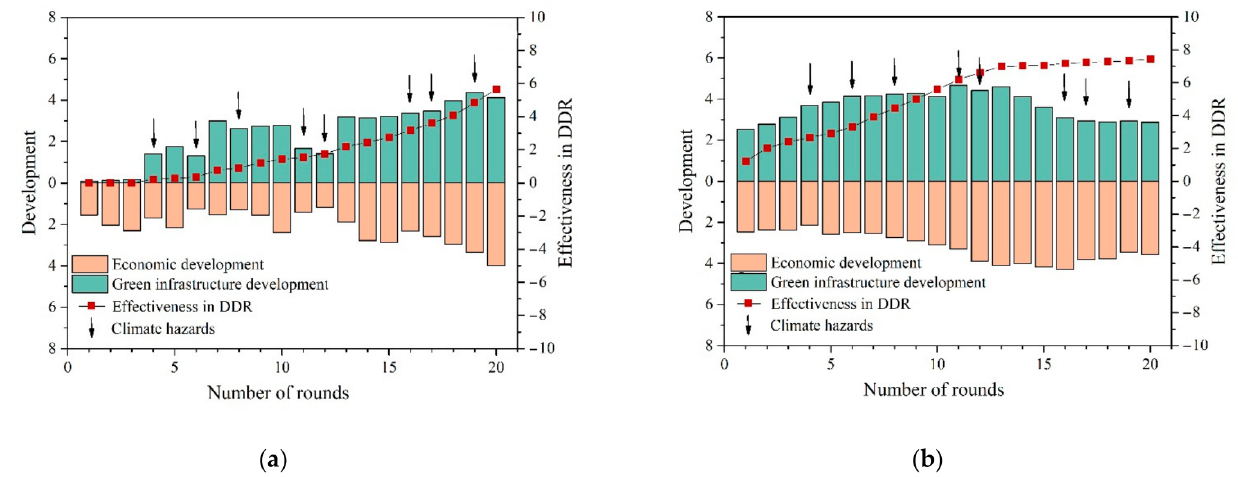
Figure 3. ( a ) Players’ decision making about trade-offs between development and DRR in T1; ( b ) players’ decision making about trade-offs between development and DRR in